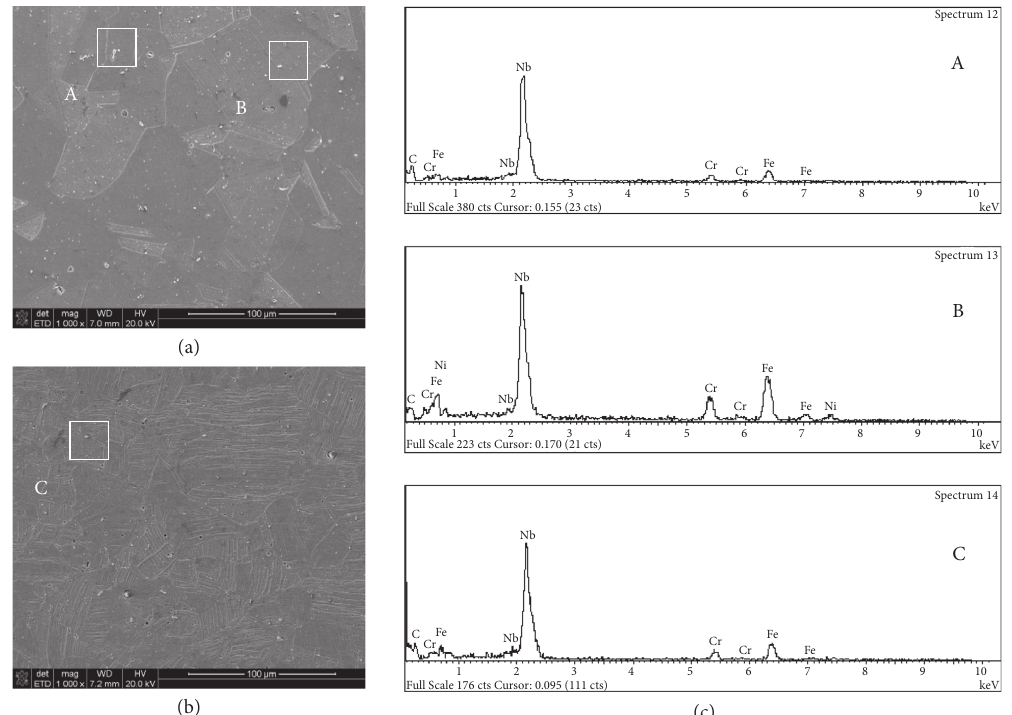
Figure 4: SEM-EDS observations of different deformation sections. (a) SEM photo of section I; (b) SEM photo of section V; (c) EDS results of SEM at each marking point.